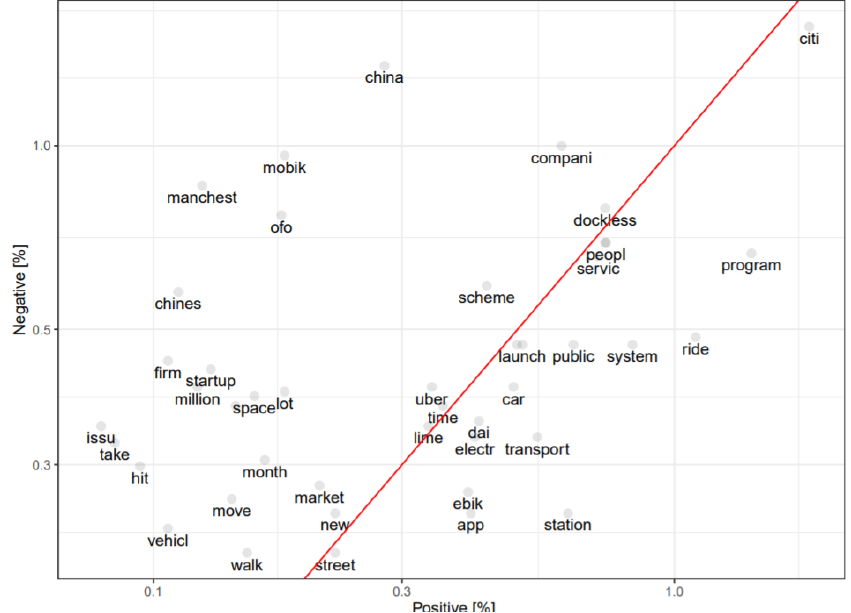
Figure 4. Words’ roots relative frequencies of positive and negative tweets Bike-sharing: The good